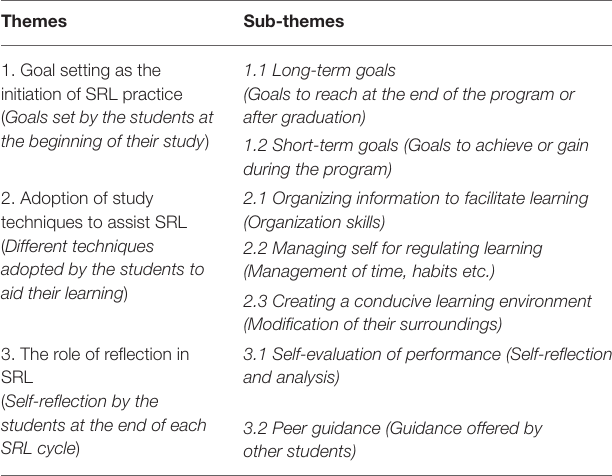
TABLE 2 | Themes on self-regulated